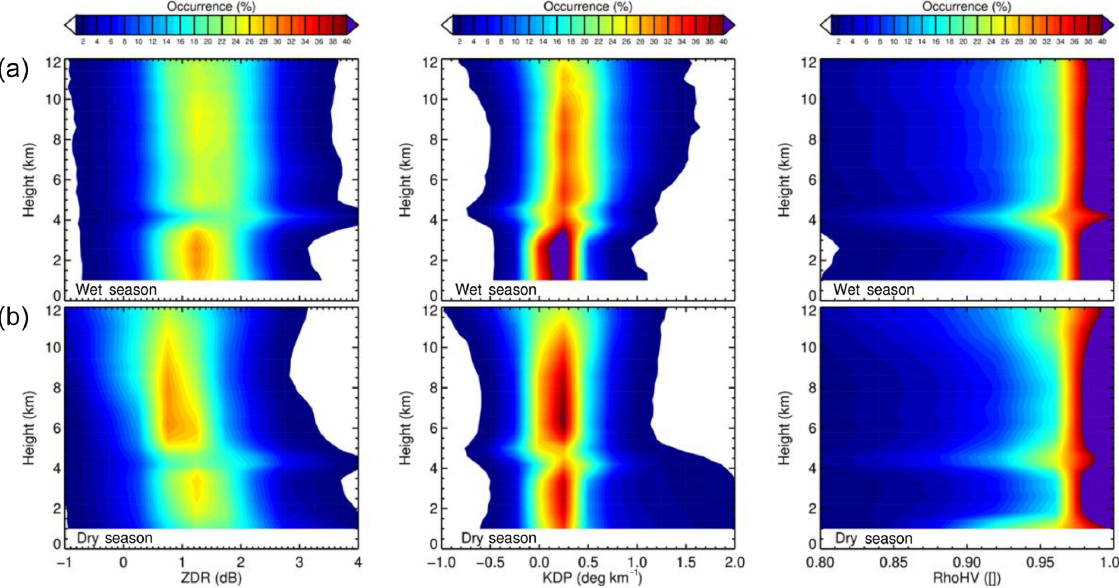
Figure 6. ZDR (gives an idea of horizontal–positively and vertical–negatively oriented hydrometeors), KDP (gives an idea of hydrometeor concentration and hydrometeor orientation), and horizontal–vertical correlation (gives an idea of the homogeneity of the hydrometeor) contoured frequency by altitude diagram (CFAD) for the wet (a) and dry (b) seasons as derived using the X-band radar. Each CFAD consists of a PDF of ZDR (0.5dB bin intervals), KDP (0.5dB bin intervals), and co-polar correlation (0.05 bin intervals) at each height (400m bin intervals) multiplied by 100 so that the values are displayed as a percentage.